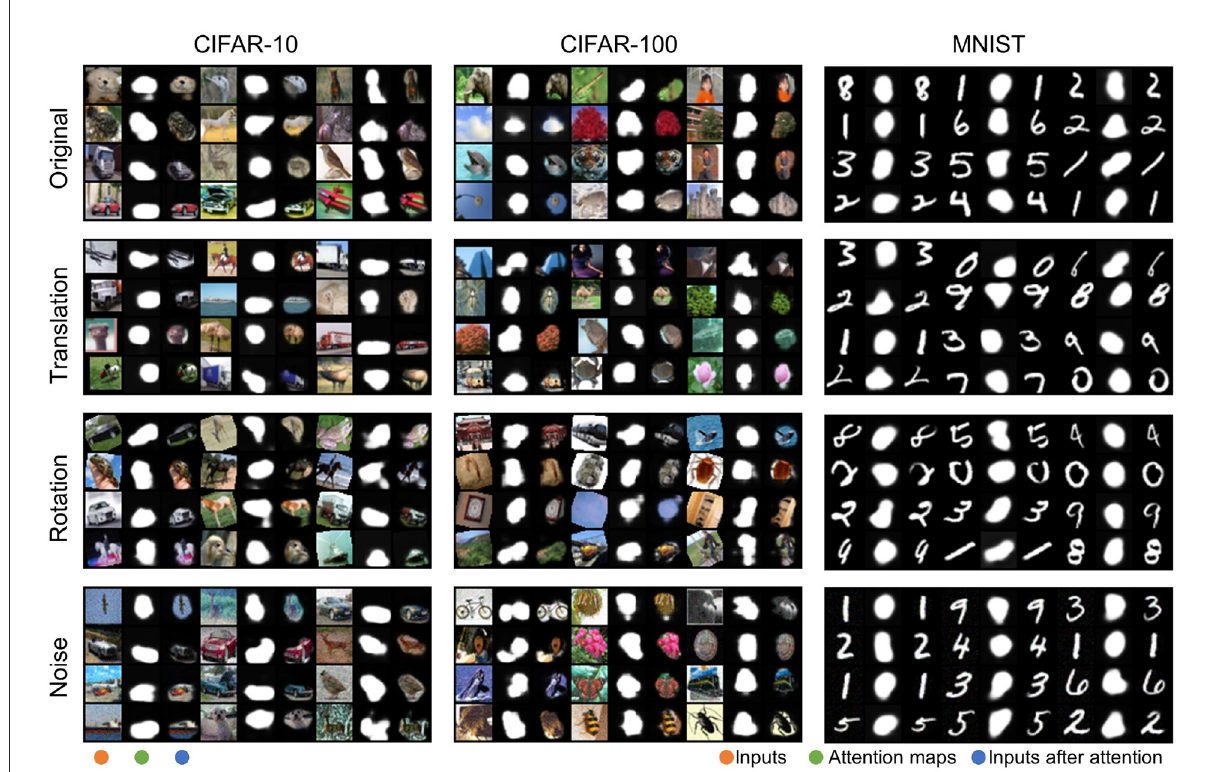
FIGURE2 Attention maps for samples in CIFAR-10, CIFAR-100, and MNIST under different settings, respectively. The images are arranged in columns for the input, the corresponding attention map, and the input after attention.